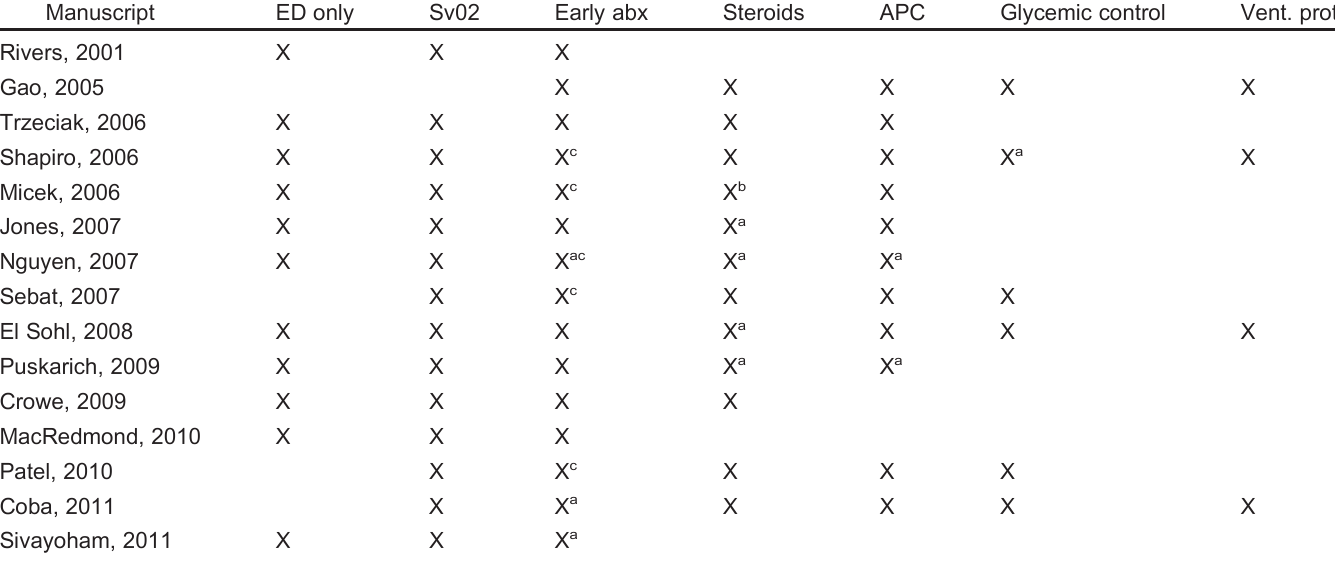
Table 2. Location of study and interventions